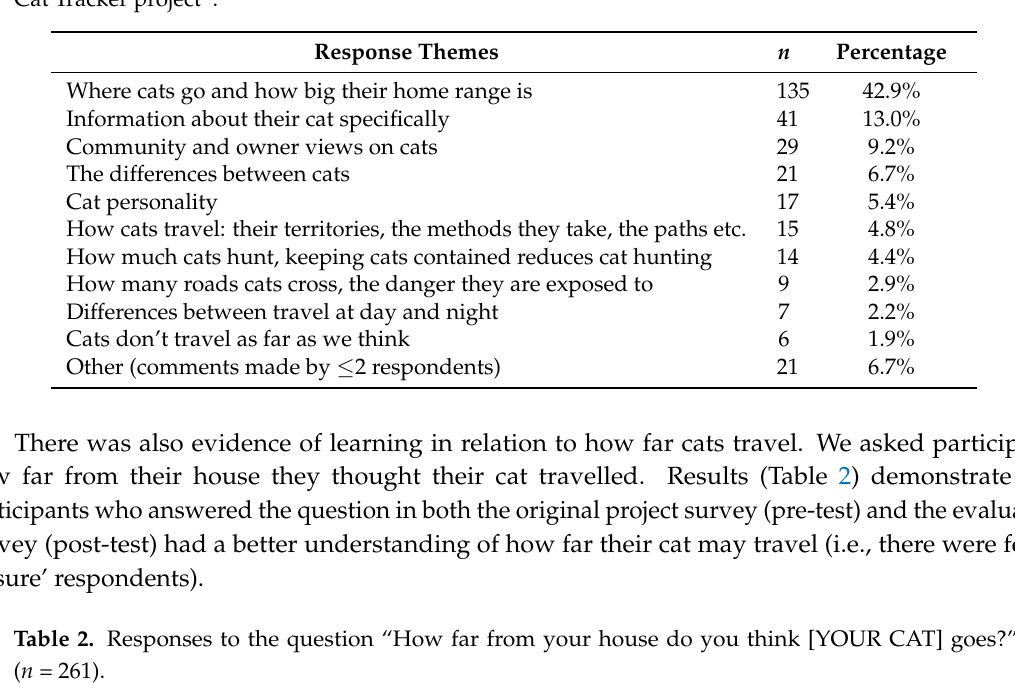
Table 1. Thematically coded responses to the question “Please tell us what you learnt as a result of the Cat Tracker project”.